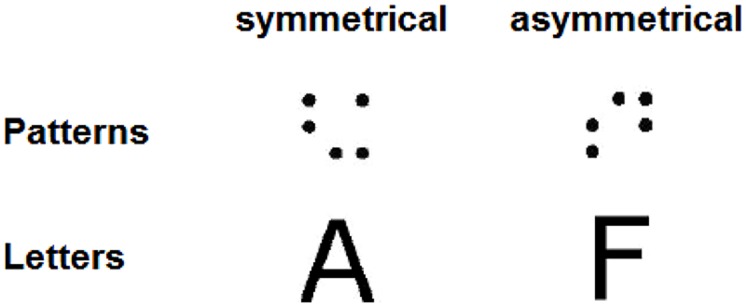
Examples of symmetrical and asymmetrical dot-pattern (first used by Garner and Clement, 1963) and letter stimuli used in Lachmann and van Leeuwen (2007).